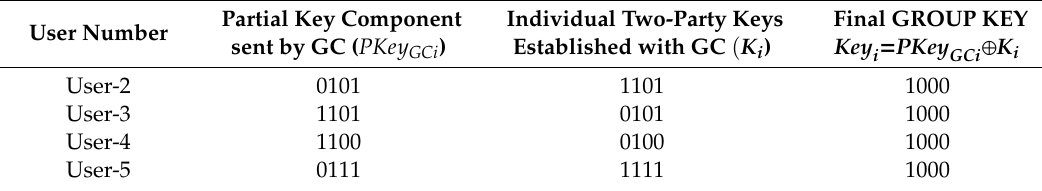
Table 6. Computation of final group key by all the users of e-healthcare.